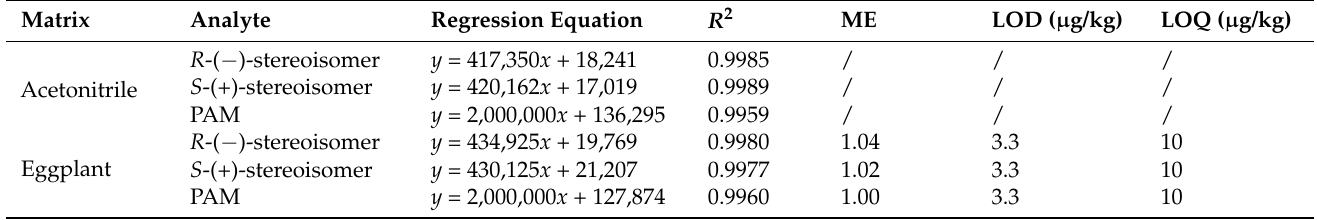
Table 1. Linear equation, determination coefficient (R2), LOD, LOQ and matrix effect (ME) of penthiopyrad stereoisomers and PAM in solvent and eggplant